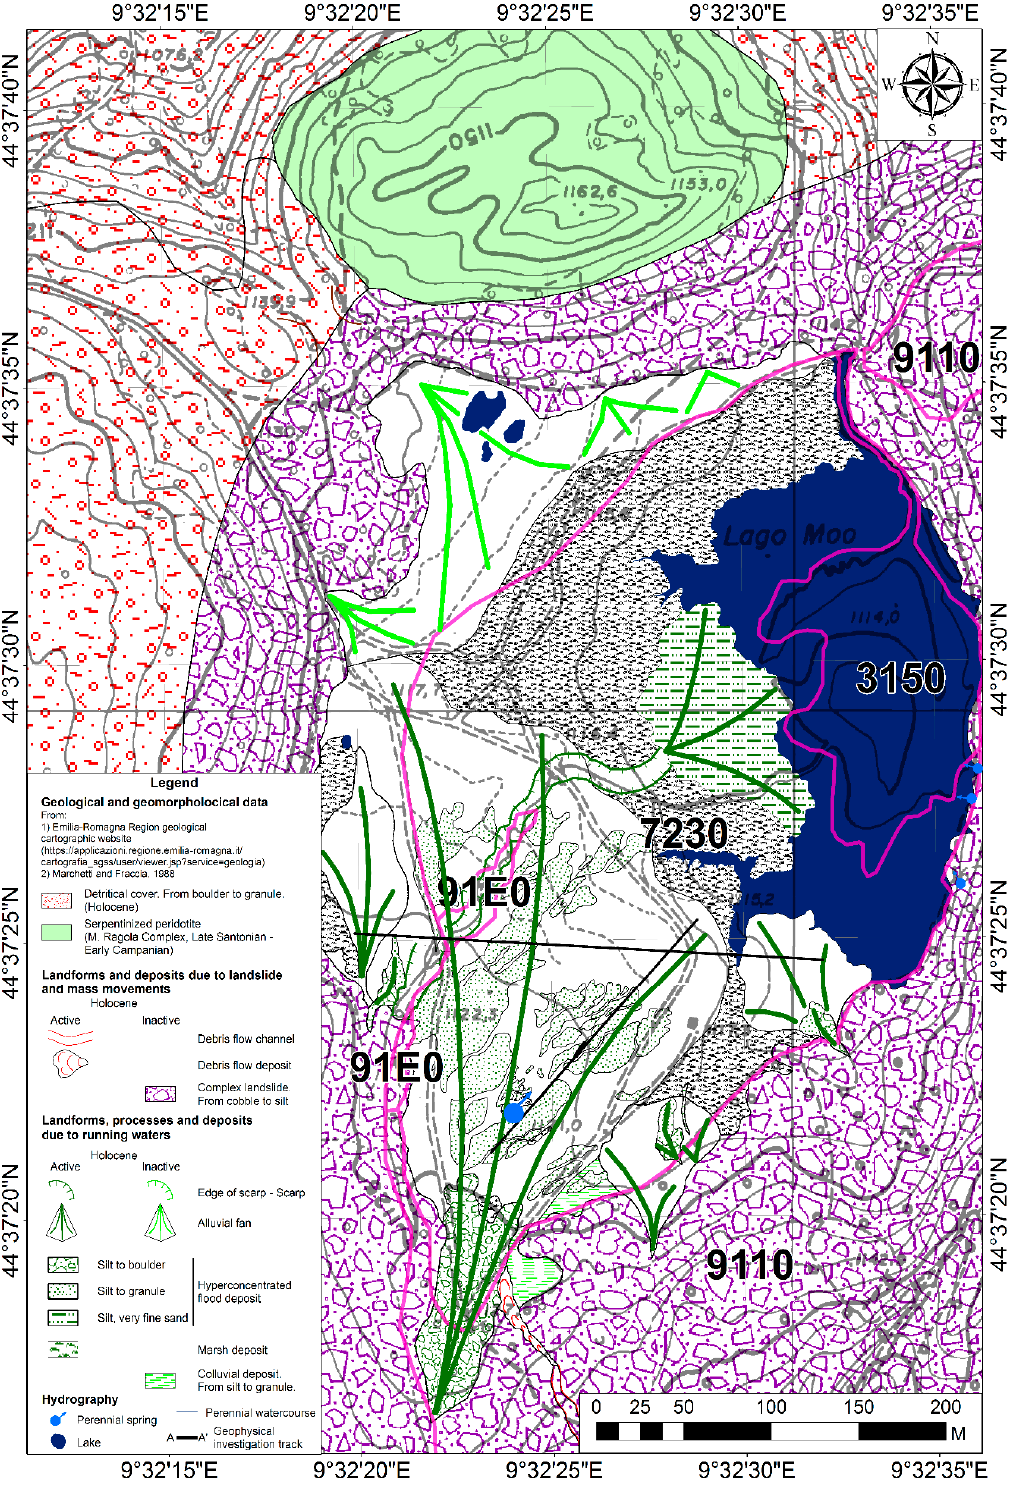
Figure 7. Original detailed geomorphological mapping of the flood deposits, related to the habitats of the Natura 2000 network (purple line), IT4020008 site code.